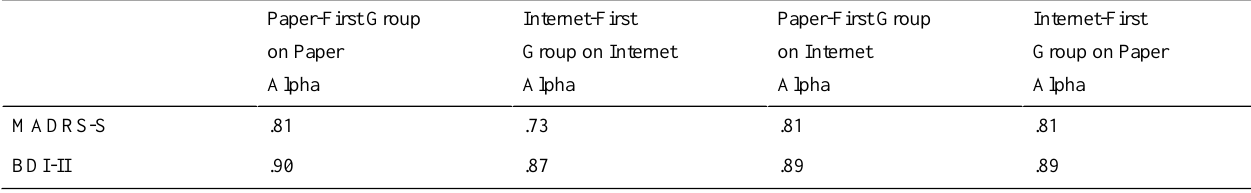
Table 1. Internal consistency (Cronbach alpha) for the two groups and administration formats